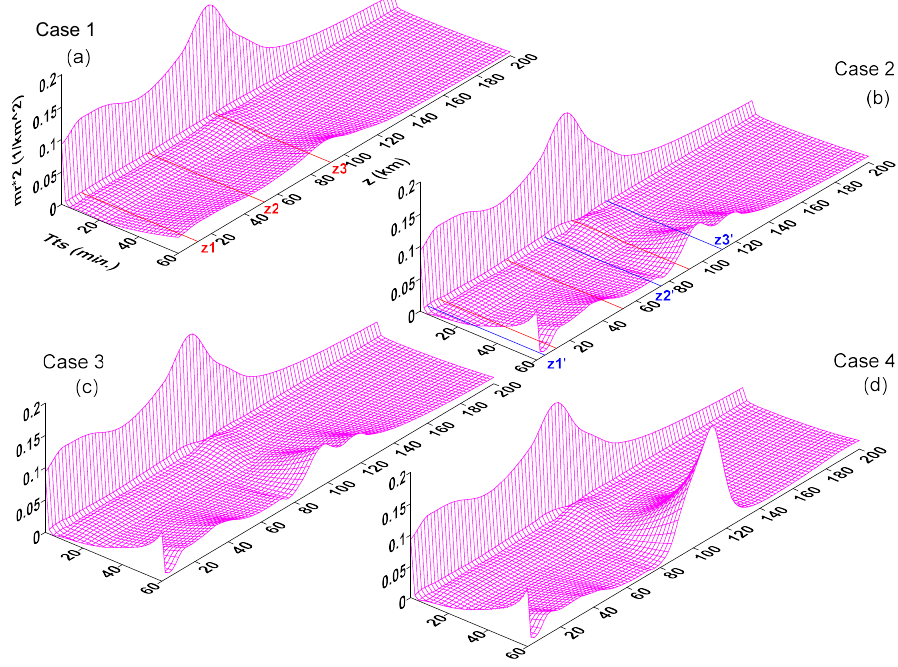
Figure 4. Squared real vertical wavenumber, m 2 r (1/km 2 ), of different tsunami-excited wave modes propagating in an atmosphere. Case 1: ( a ) Hines’ locally-isothermal and shear-free model; Case 2: ( b ) the extended Hines’ model under nonisothermal conditions; Case 3: ( c ) inertio-acoustic-gravity waves under nonisothermal conditions; Case 4: ( d ) acoustic-gravity waves under non-isothermal and wind shear conditions. Note that there exists a “quasi-straight line” of m 2 r = 0 in every panel throughout all altitudes at ∼ 4 min in the tsunami period. This line separates the acoustic waveband of < 4 min in wave periods from the gravity waveband of > 4 min in wave periods. In (a), there are three straight lines in red, which are located at z 1 ∼ 12 km, z 2 ∼ 50 km and z 3 ∼ 90 km, respectively, to separate the space into three regions; in (b), there are three additional straight lines in blue, which ∼ 4.5 km, z (cid:48) ∼ 75 km and z (cid:48) ∼ 110 km, are located at z (cid:48) 2 3 1